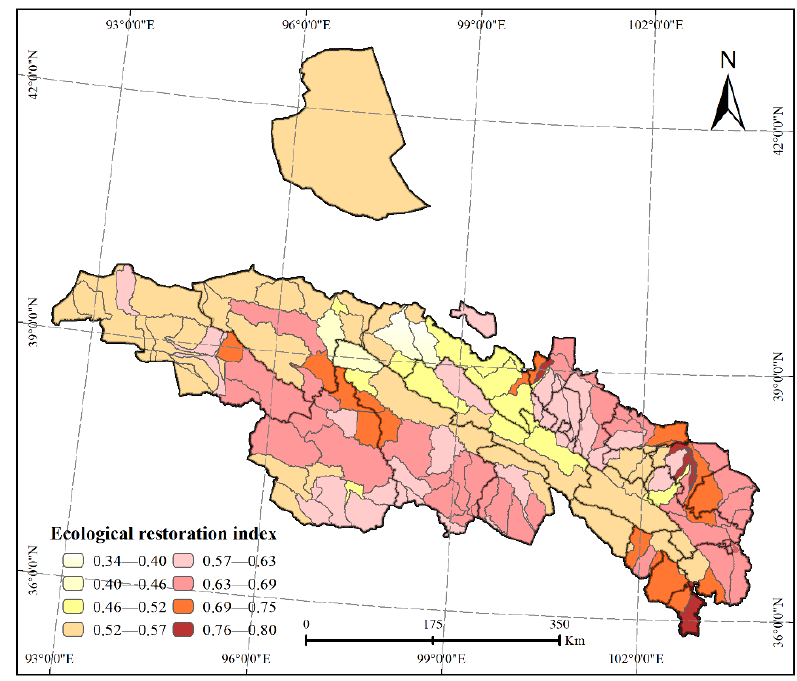
Figure 5. Ecological restoration index (ERI) of the Qilian Mountains.